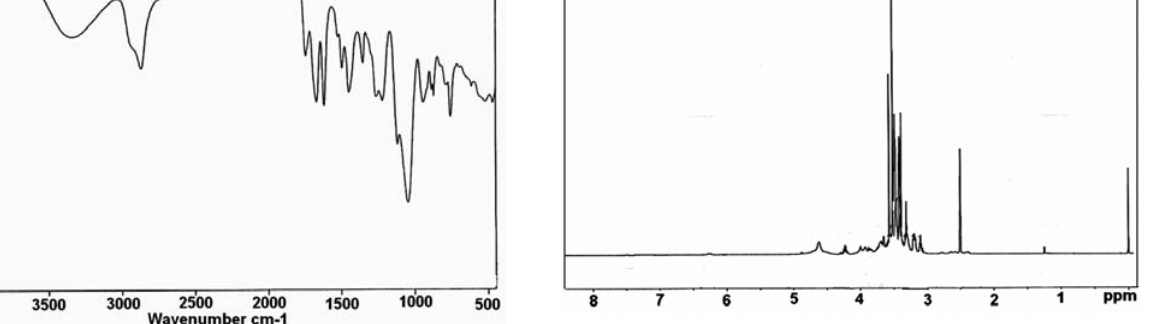
Fig. 2. IR spectrum of oligoetherol obtained from mMPP:EC=1:22